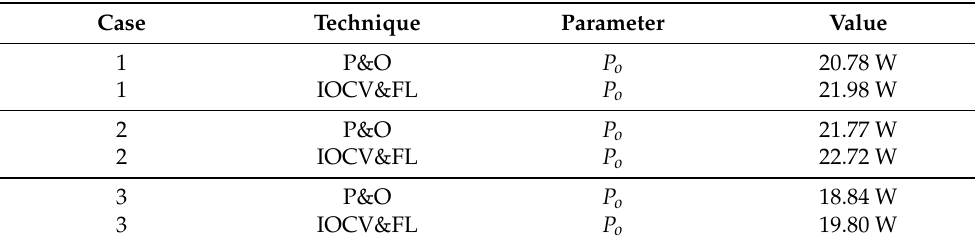
Table 2. Results obtained from simulation.